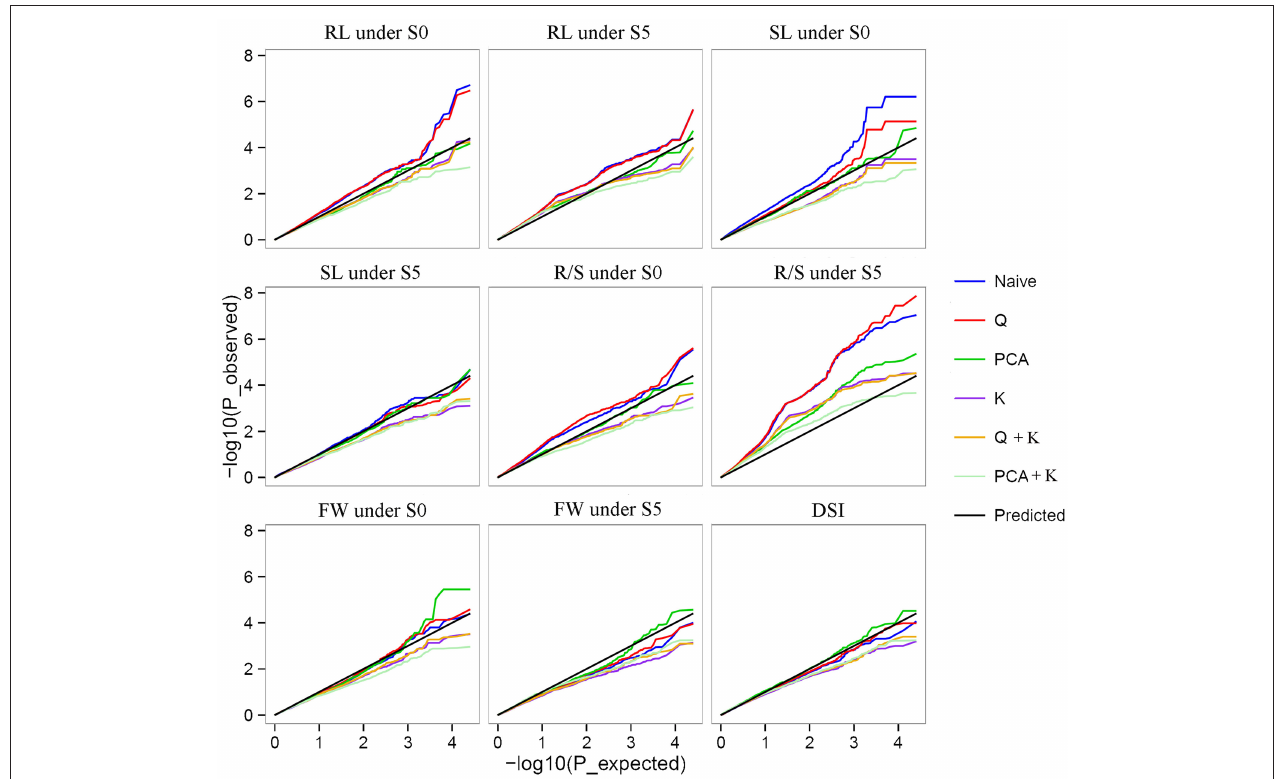
FIGURE 2 | Quantile-quantile plots of estimated − log 10 (p) from association analysis using six models for drought stress index (DSI) and four traits under normal (S0) and water stress (S5) conditions. Root length (RL) under S0 and S5; Shoot length (SL) under S0 and S5; Root to shoot length ratio (R/S) under S0 and S5; Fresh weight (FW) under S0 and S5; Drought stress index (DSI).